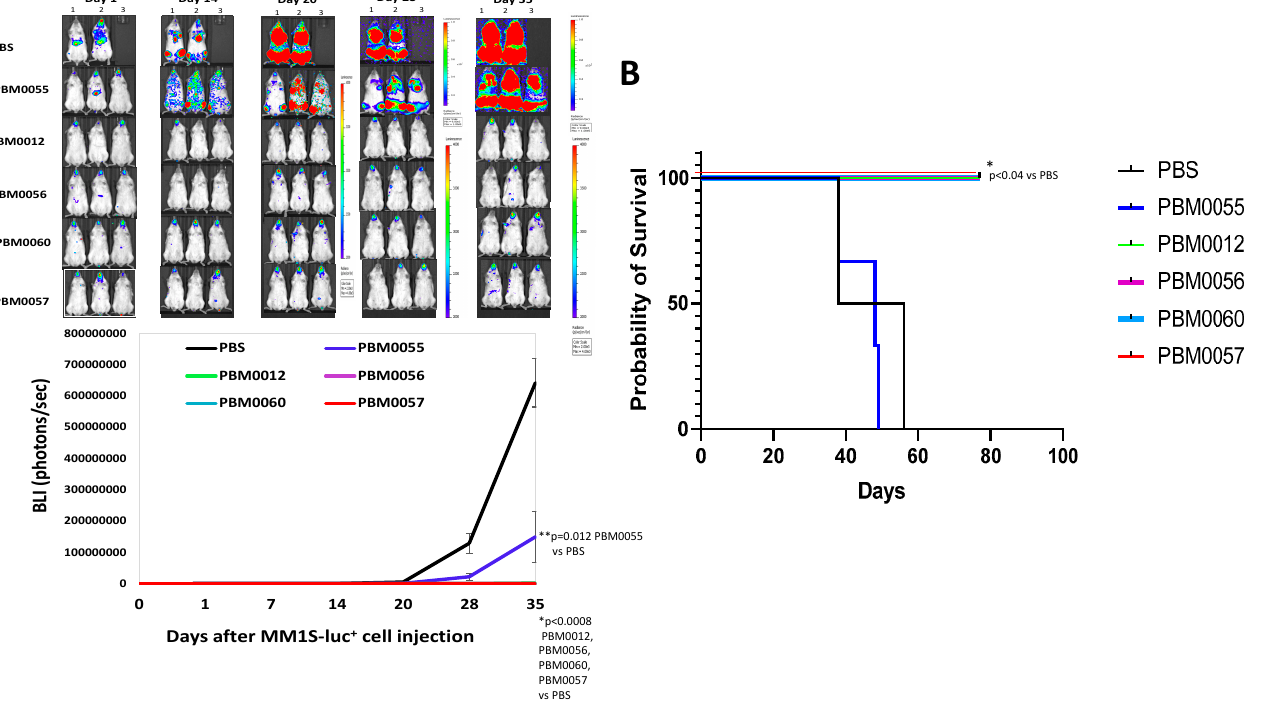
Figure 5. BCMA-CD3 antibodies with T cells significantly decrease MM1S-luciferase+ tumor growth. ( A ) Imaging of MM1S-luc xenografts with BCMA-CD3 antibodies and T cells. The PBS-treated group had two mice; all BCMA-CD3-treated groups had three mice per group ( n = 3). Upper panel: Images of mice. Lower panel Quantification of BLI (photons/sec). ** p < 0.0008, BLI for PBM0012, PBM0056, PBM0060 and PBM0057 versus PBS group. ** p = 0.012, BLI for PBM0055 versus PBS-group, Student’s t -test. ( B ) Kaplan Myer survival curve. p < 0.04 all antibodies vs. PBS control by Log-rank Mantel-Cox test.